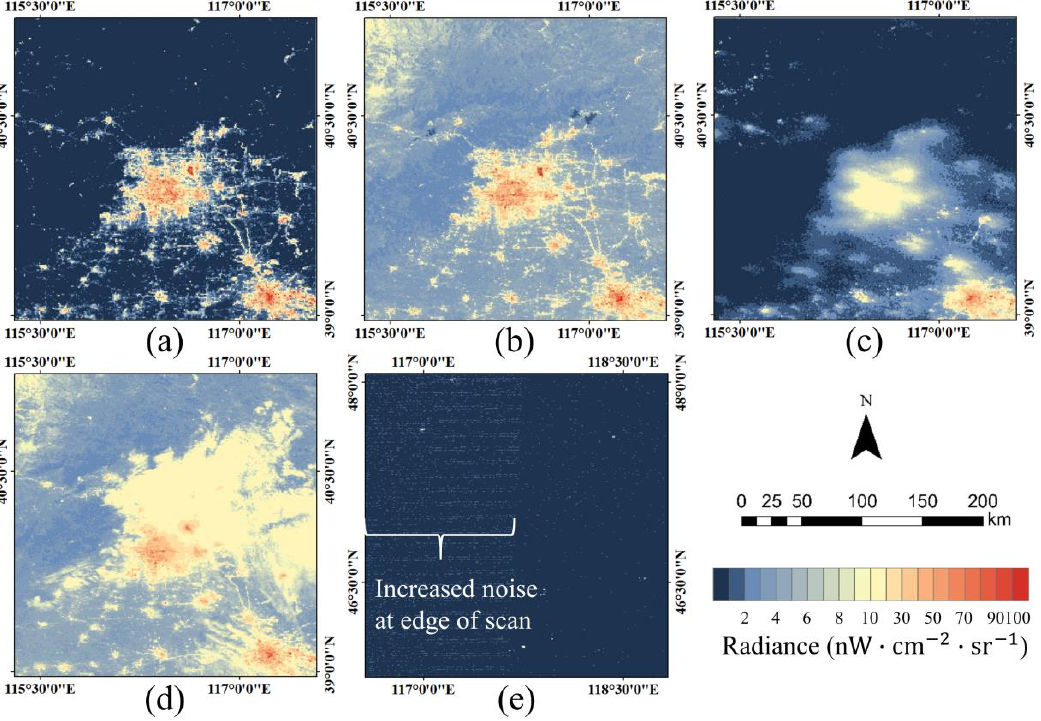
Figure 2. National Polar-orbiting Partnership Visible Infrared Imaging Radiometer Suite (NPP-VIIRS) Day/Night Band (DNB) images under different conditions: ( a ) no moonlight or cloud, ( b ) moonlit, ( c ) cloudy, ( d ) moonlit and cloudy, and ( e ) edge-of-swath.